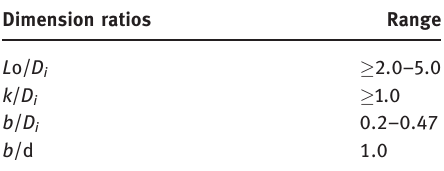
Table 1: The recommended TBS dimension ratio ranges for a constant D i .